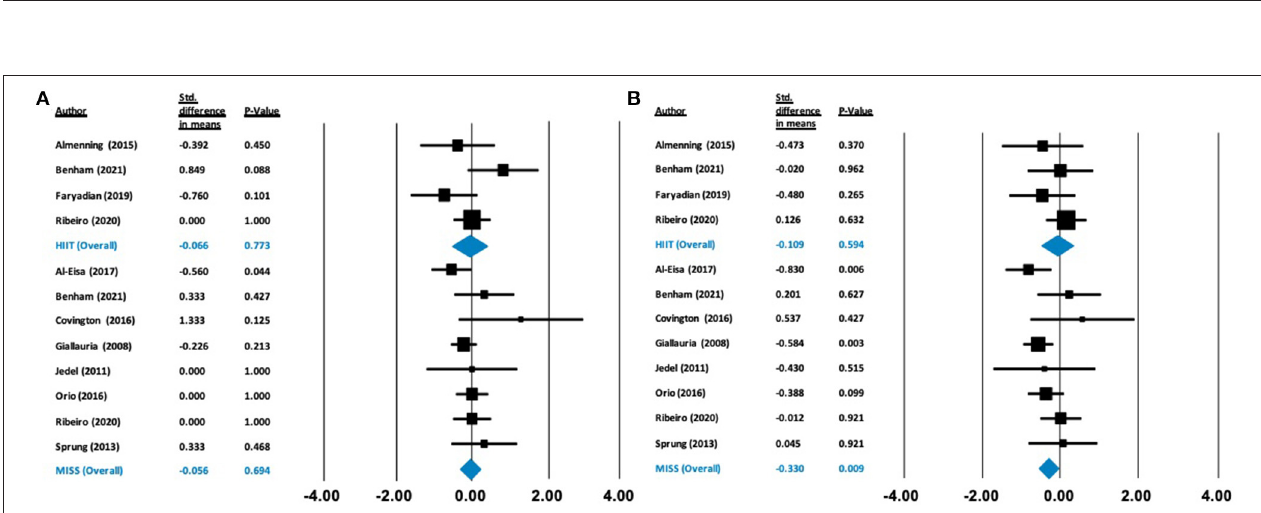
FIGURE 5 | Forest plots of standard difference in means 95% profile. Filled squares represent study outputs. Lines represent 95% confidence intervals. Filled blue diamonds represent the weighted mean determined through